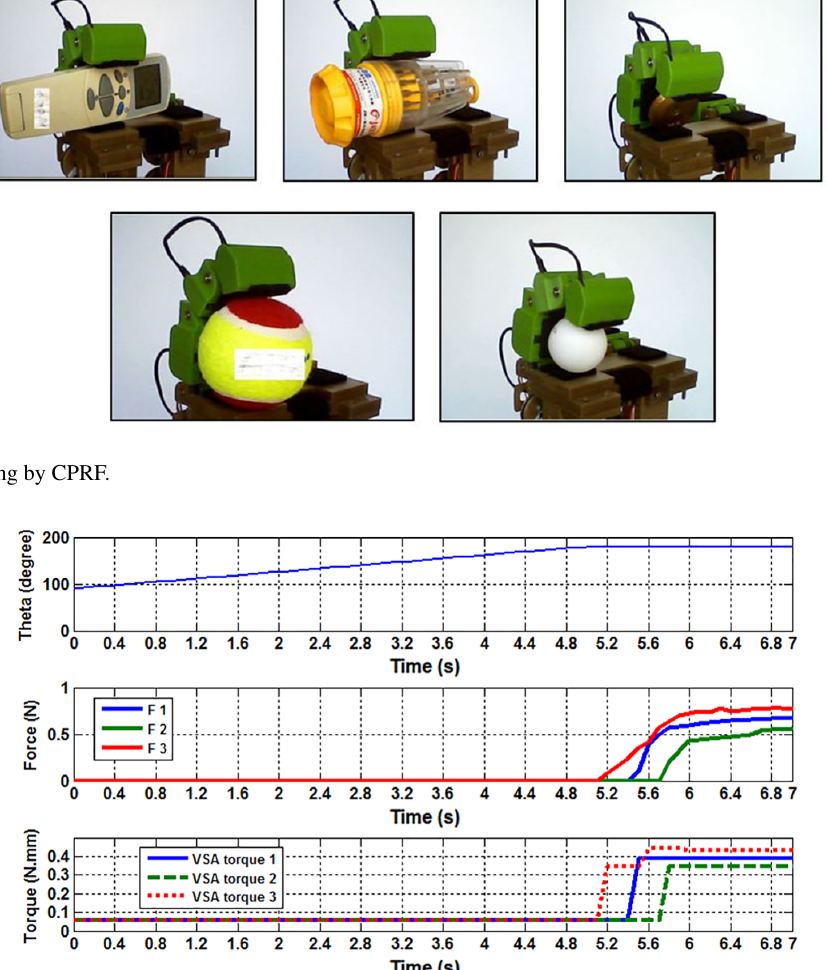
Figure 22. CPRF system response to the applied control